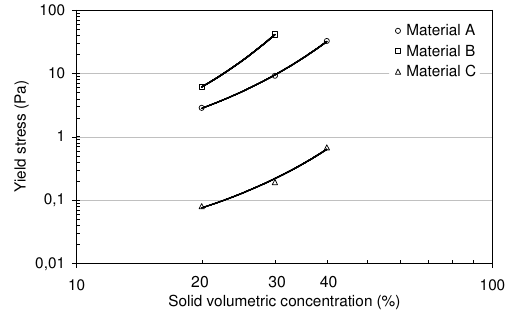
Fig. 7. Yield stress τ y vs. solid volumetric concentration C v . Fine particle mixture yield stress is observed. This reduction may be justified by a Cvf 0.3, CvL 0.0 decrement of finer content, the yield stress tends to disappear Large particle mixture Cvf 0.2, CvL 0.1 due to a reduction of the fine fraction (clean water). This behaviour is in agreement with the experimental re- sults of Ancey and Jorrot (2001) on coarse particles within a clay dispersion with a parallel plates system. When the large particle fraction is small compared to the amount of fine particle fraction, the colloidal fine fraction determines the rheological features of the shear rate (1/s)